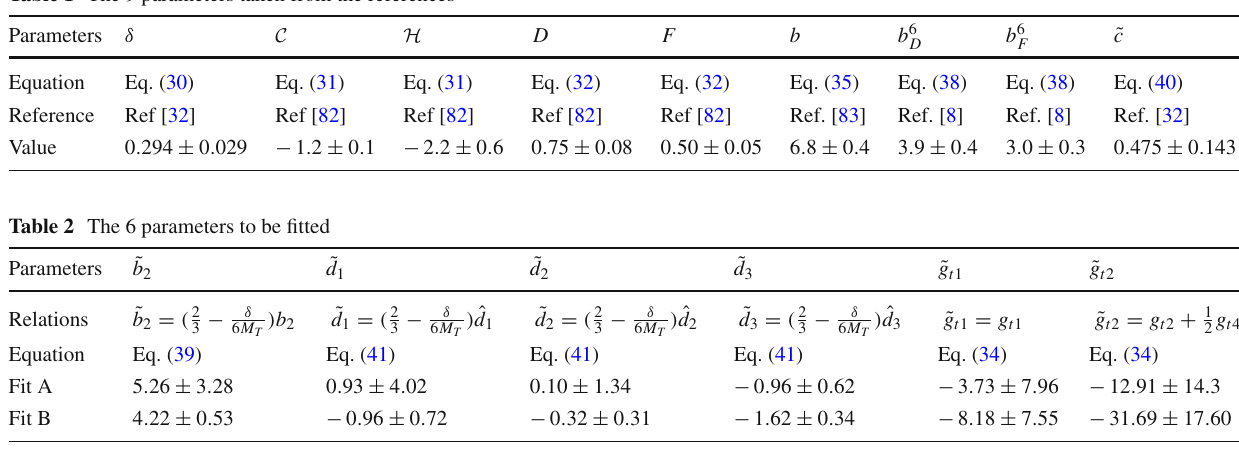
Table 1 The 9 parameters taken from the references